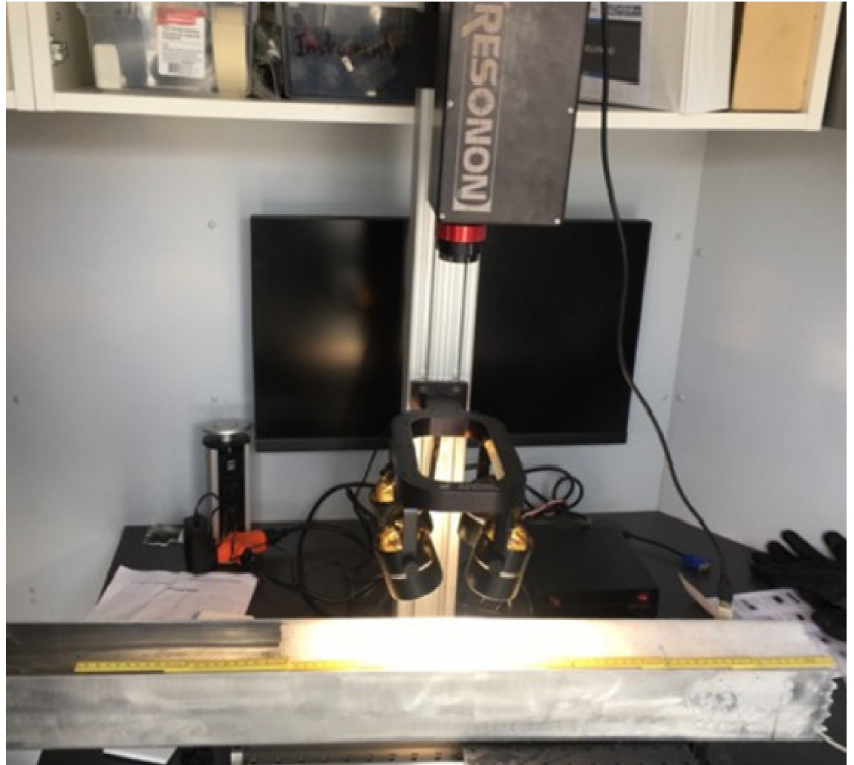
Figure 6. Hyperspectral acquisition of the snow samples’ vertical